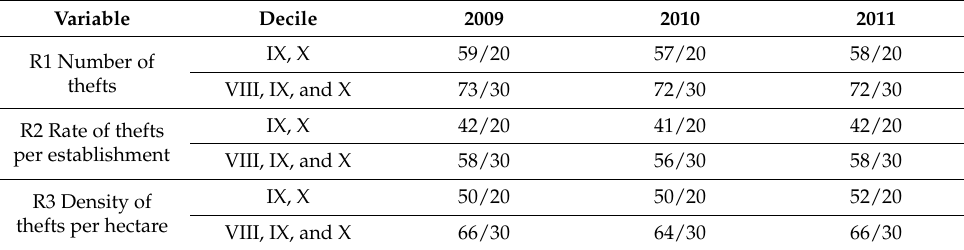
Table 1. Concentration ratios for R1, R2, and R3 in